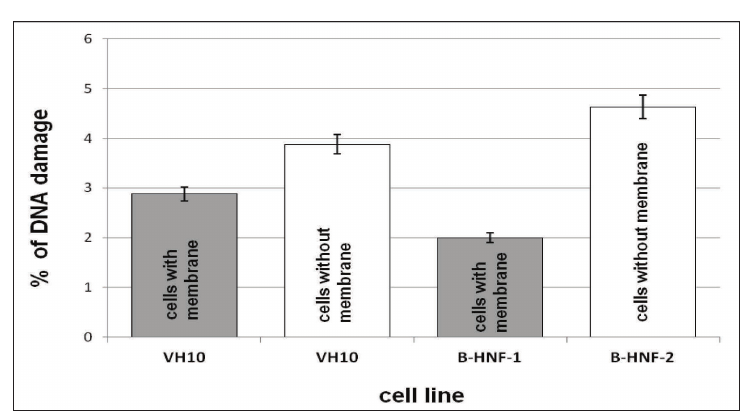
Fig. 6. Fluorescence microscopic analysis of DNA damage of VH10 (A) and B-HNF-1 (B) cells growing 24 h with/without the coladerm-beta glucan membrane. Magnification